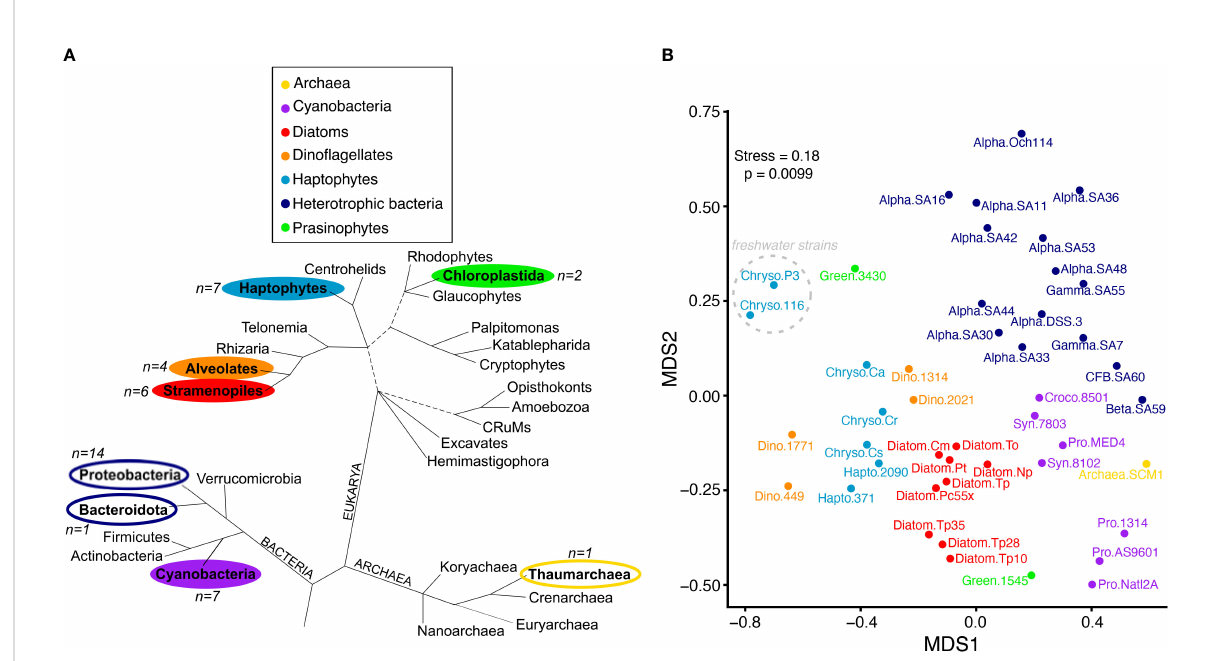
FIGURE 1 Metabolite pro fi les re fl ect taxonomy. (A) Major lineages of marine Bacteria, Archaea and Eukarya adapted from (Burki et al., 2020). Branch lengths are not drawn to scale, unresolved branching orders are shown as multifurcations, and uncertainties in the monophyly of groups are shown as broken lines. Lineages included in this study are in bold and colored according to the taxonomic groups shown in the legend that correspond to panel (B) The number of representatives used in this study from each lineage is indicated by n =X, with phytoplankton lineages indicated by fi lled colors and heterotrophic bacteria and archaea un fi lled. B) NMDS ordination plot based on Jaccard distance using presence- absence of 111 metabolites. Metabolites similar to background levels were treated as absent. Organisms are labeled according to taxonomic group and strain ( “ group.strain ” as in Table 1). The two freshwater Chrysochromulina strains are noted with the dashed gray circle. Colored taxonomic group abbreviations are the following: Cyanobacteria (purple; Croco, Crocosphaera ; Pro, Prochlorococcus ; Syn, Synechococcus ); Archaea (yellow), Haptophytes (light blue; Chryso, Chrysochromulina ; Hapto, Emiliania ), Diatoms (red), Dino fl agellates (orange), Heterotrophic Bacteria (dark blue; Alpha, alphaproteobacteria; Gamma, gamaproteobacteria; Beta, betaproteobacteria; CFB, Cytophaga-Flavobacterium- Bacteroides); Prasinophytes